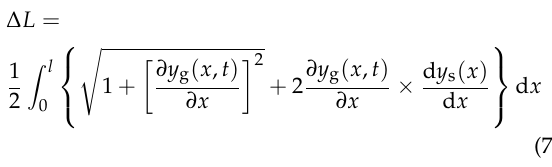
Fig. 5. Expansion drawing of the